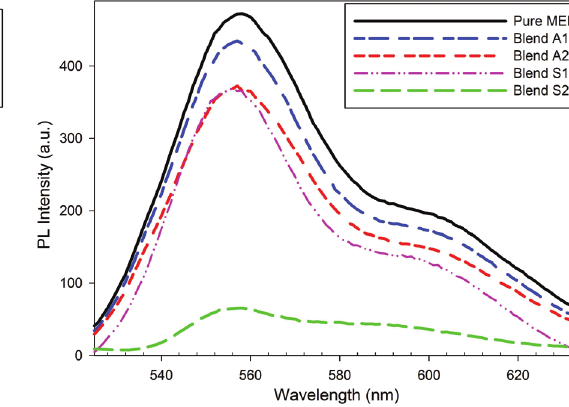
Figure 12 Photoluminescence (PL) of pure MEH-PPV and BHJSC active layer blends A1, A2, S1, and